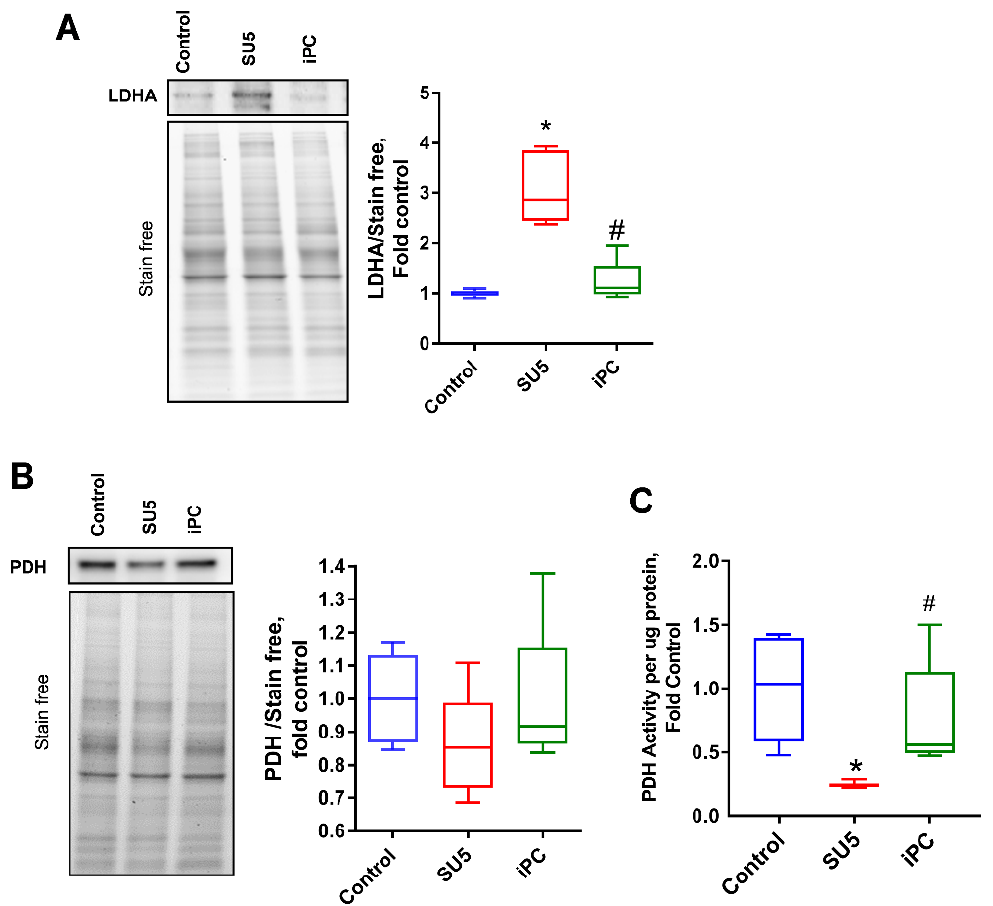
Figure 5. PC inhibitor controlled the balance between lactate dehydrogenase (LDH) and pyruvate dehydrogenase (PDH) in PAH. ( A ) Lactate dehydrogenase (LDHA) increased in the SU5 group was significantly reduced with PC inhibitor treatment. ( B ) Total PDH expression was not significantly altered, but ( C ) PDH activity significantly attenuated in the SU5 PAH group, and PC inhibitor treatment reduced this back to the control level. Data expressed as box-and-whisker plot with median value ± min max, * p < 0.05 versus control, # p < 0.05 versus SU5 by ANOVA.